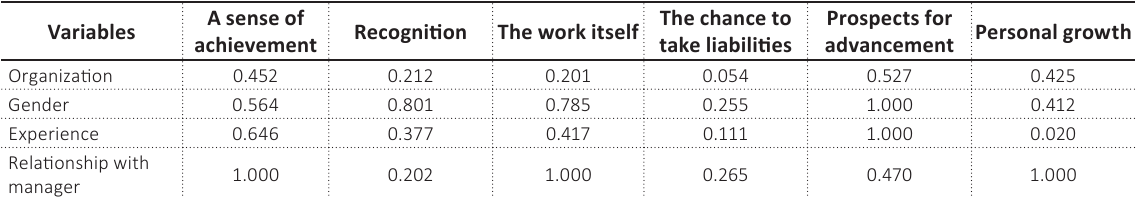
Table 5. Effect of organization, gender, experience, and relationship with the manager on the choice of the best source of motivation ( p -value)